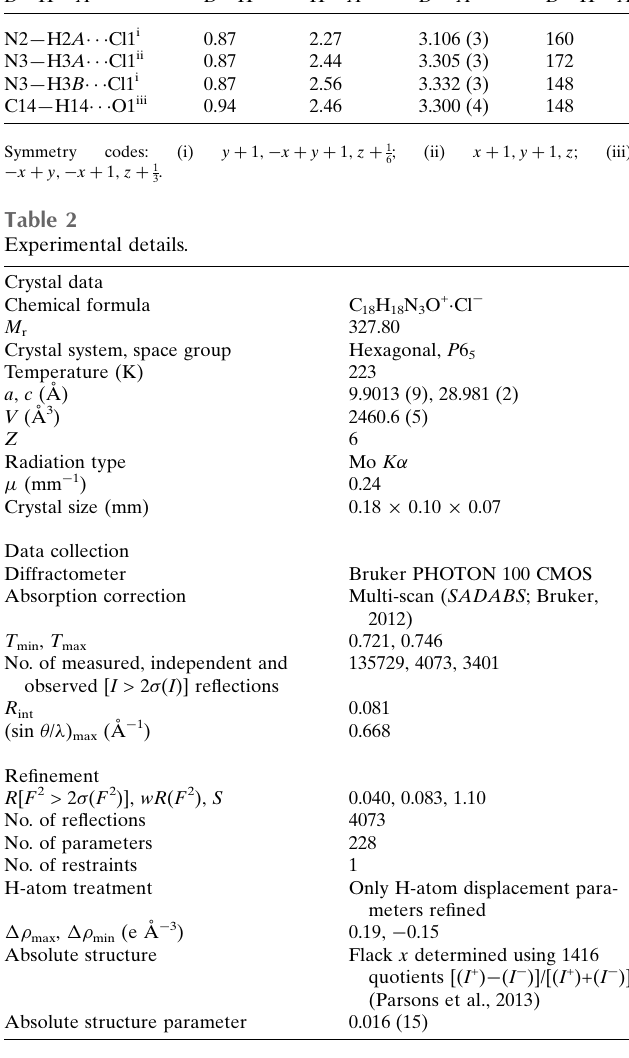
Table 1 Hydrogen-bond geometry (A˚ , (cid:4) ).